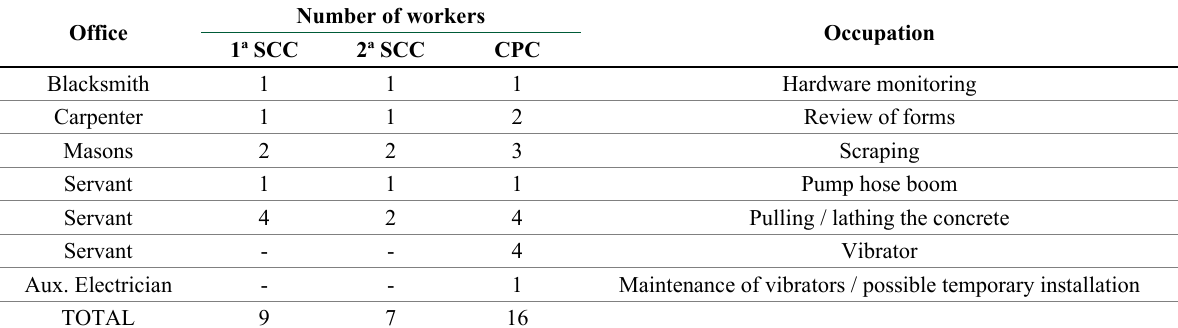
Table 5. Distribution of non-administrative collaborators of the work in the 3